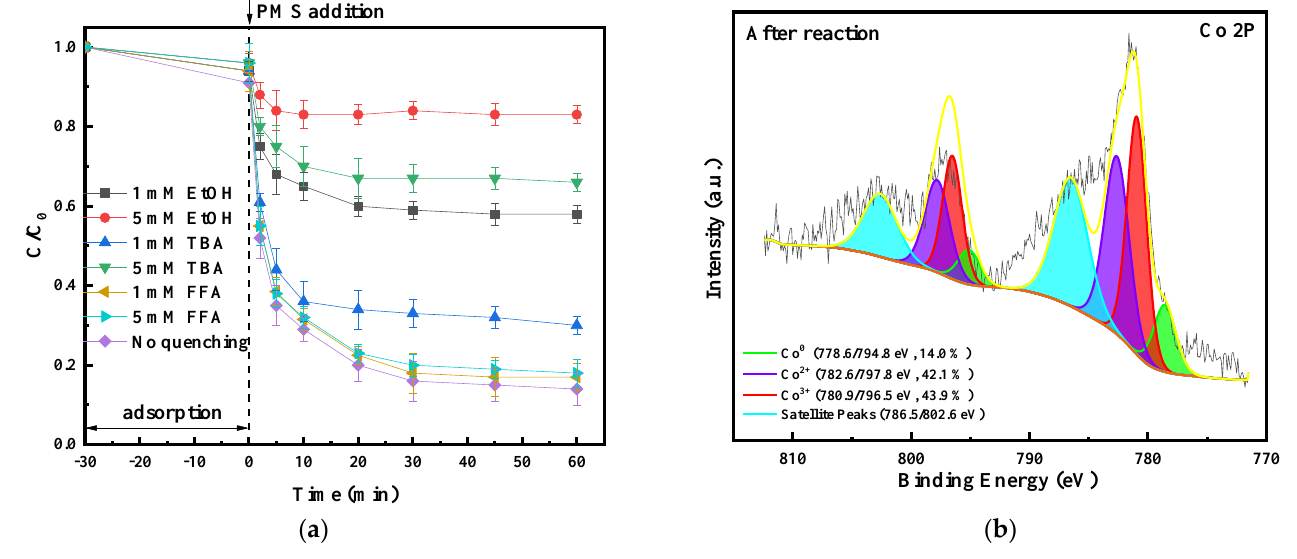
Figure 8. ( a ) Effects of radical scavengers on DMP degradation. ( b ) Co 2p XPS spectra of the ZP600 after reaction. Reaction conditions: initial solution pH = 8.5, catalyst = 0.1 g/L, PMS = 0.5 mM, and DMP = 6 ppm.